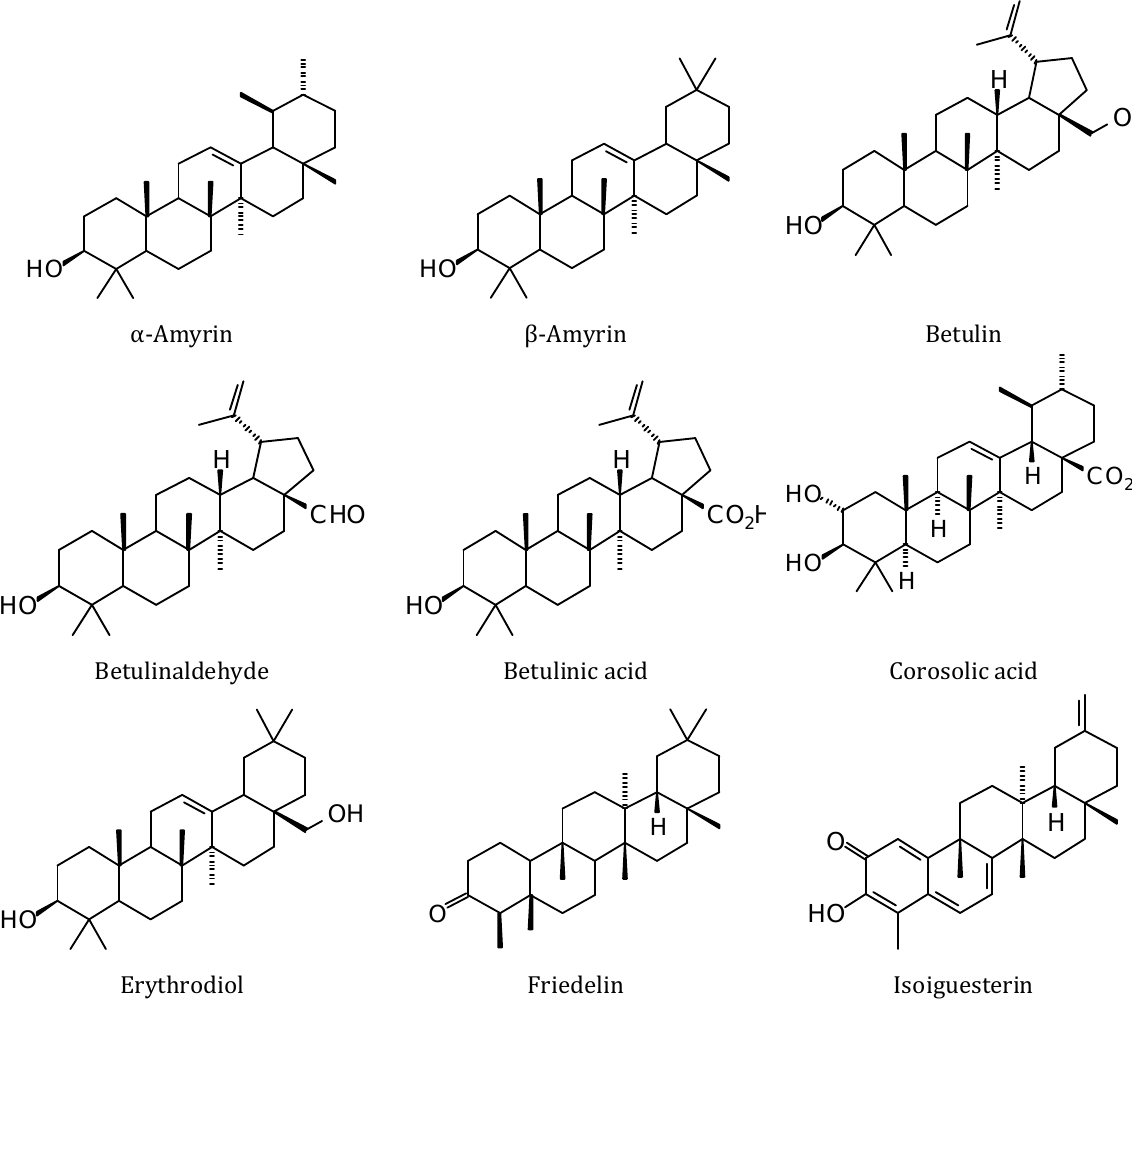
Figure 20. Triterpenoids examined in this